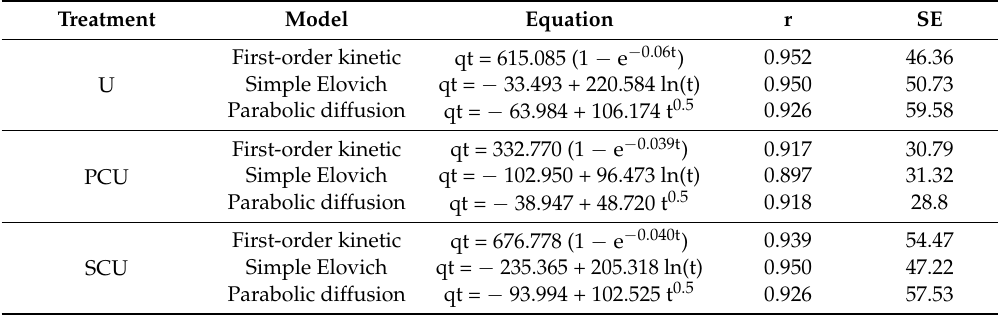
Table 3. Dynamic characteristics of NO 3 − in soil.